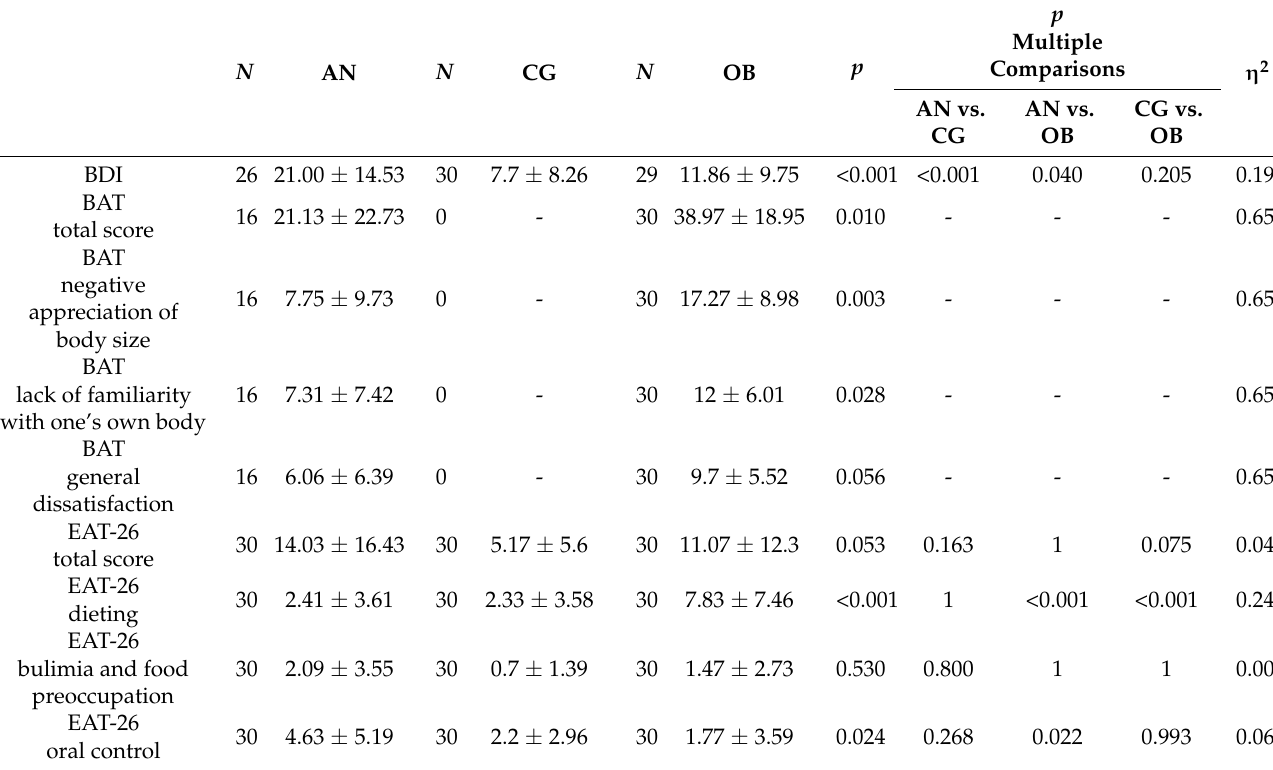
Table 2. The Beck Depression Inventory (BDI), the Body Attitude Test (BAT), and the Eating Attitude Test (EAT-26) scores in adolescents with anorexia nervosa (AN) or obesity (OB), as well as in the healthy control group (CG).